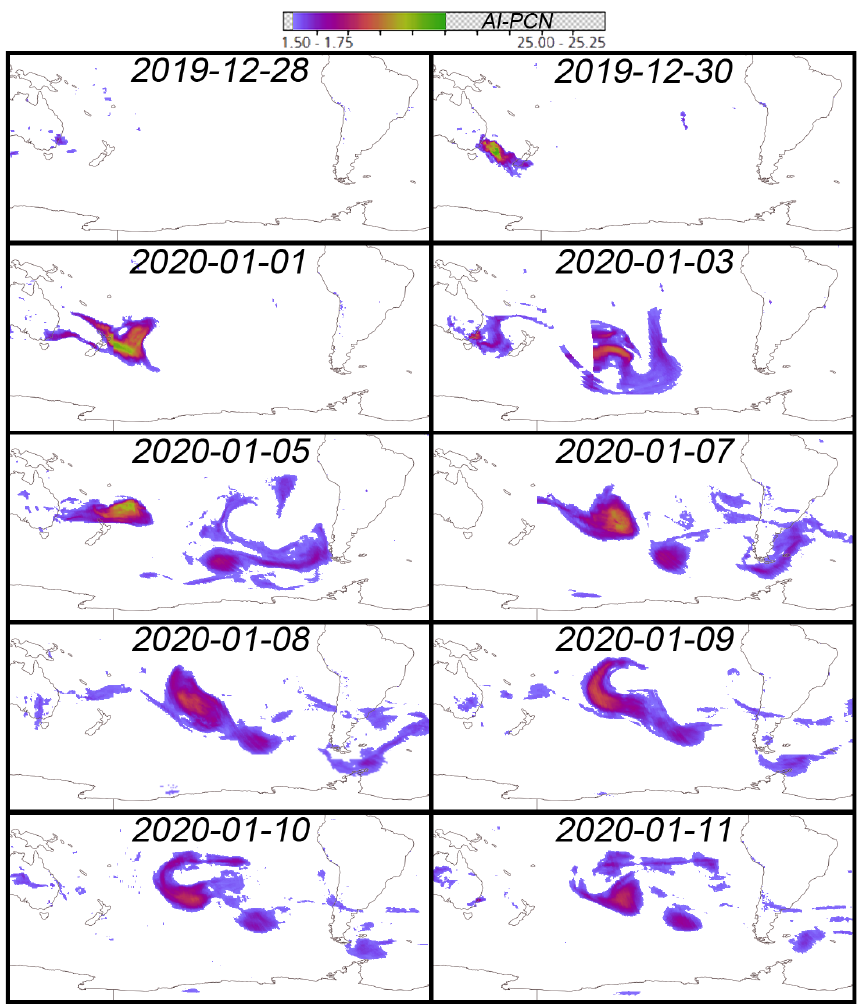
Figure 5. Aerosol Index PyroCumuloNimbus (AI-PCN) maps over Pacific ocean for 10 different days during the smoke transport from Australia to Marambio station. These maps have been extracted from NASA’s Earth Observing System Data and Information System (EOSDIS) worldview tool